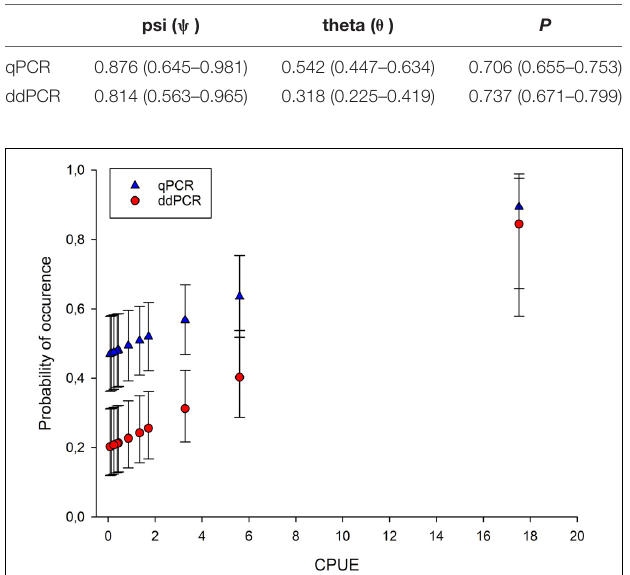
Frontiers in Environmental Science |